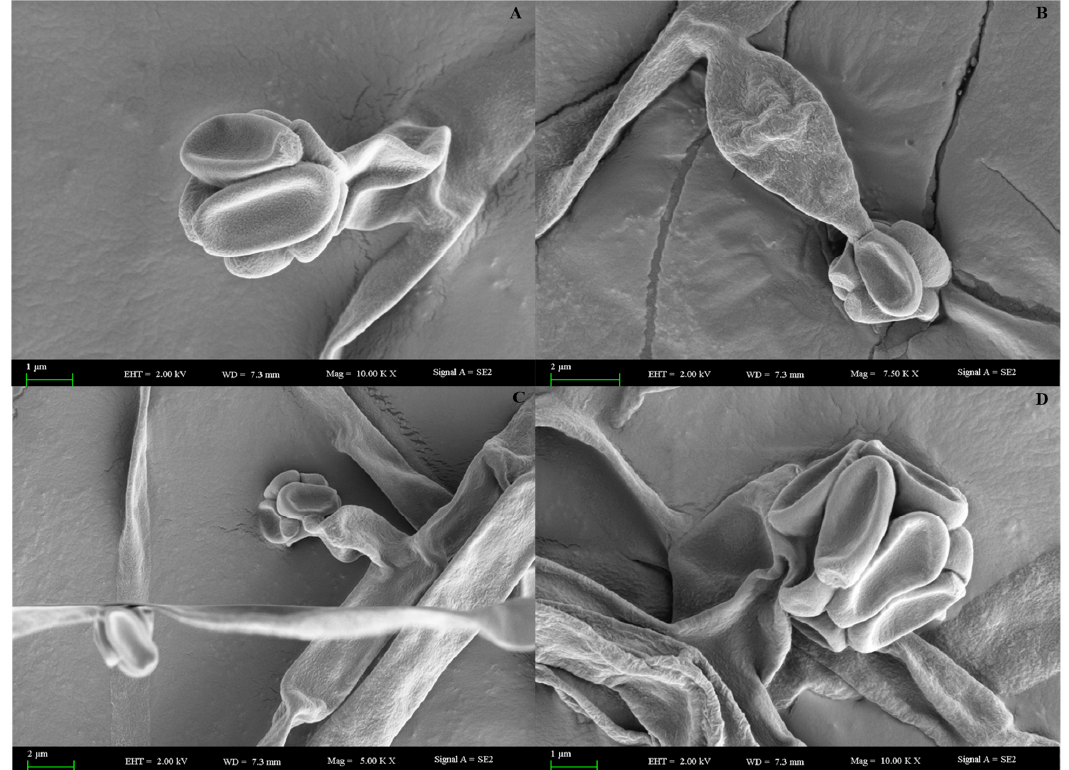
Figure 5. Microscopical view of O. senegalensis NR-03 conidial heads ×1000, ×750 ( A and B ) and ( C and D ) hyphae ×500, mycelium ×1000 and conidiophore.